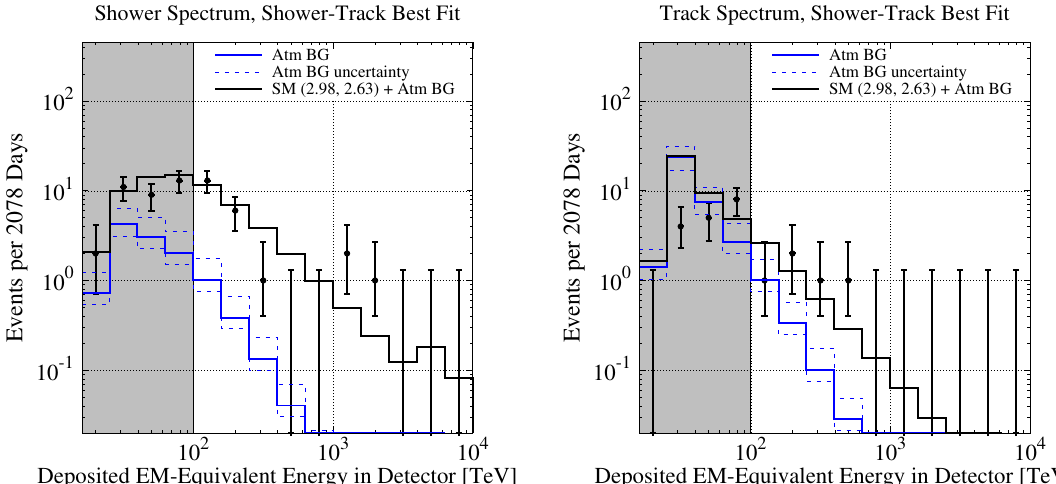
Figure 6 . Standard Model best (cid:12)t of the IceCube 6-year dataset in the energy range [100 TeV, 10 PeV], which gives the values (cid:13) = 2 : 98 and C 0 = 2 : 63 GeV cm (cid:0) 2 str (cid:0) 1 s (cid:0) 1 for the neutrino (cid:13)ux parameters. The atmospheric background is computed from the estimated central values given in ref. [77], from which we obtained N (cid:22) = 25 : 2 and N atm = 15 : 6. The points in the grey region